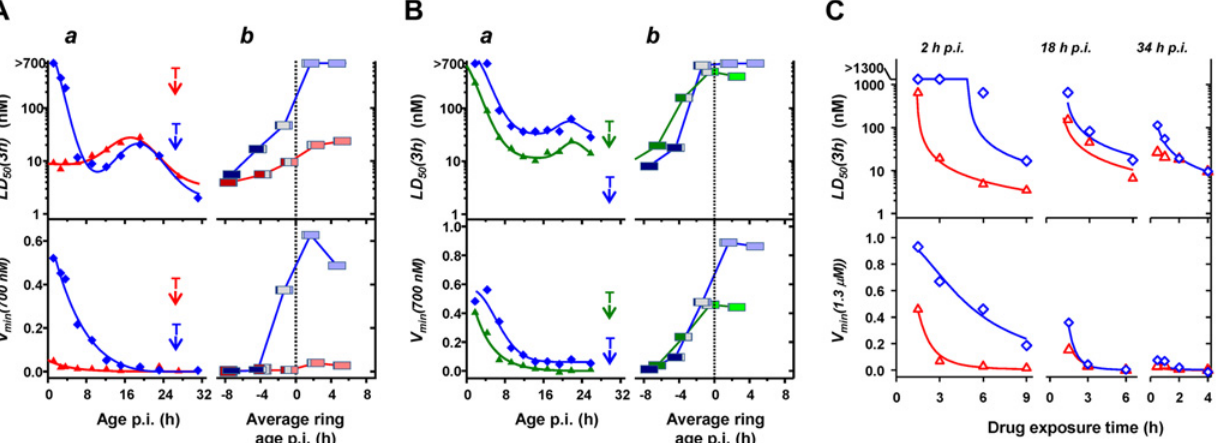
Fig 1. Stage-dependent in vitro DHA responses of Pailin strains. (A,B) Tightly synchronized PL2 and PL7 (A, red and blue, respectively) and PL1 and PL5 (B, green and blue, respectively) cultures were assayed using 3-h DHA pulses across the blood cycle. The a panels show the variation of LD 50 (3h) and V min (3h) during the first 32 h p.i. Time points corresponding to 50% trophozoites (T; filled cytoplasm in Giemsa stained smear) are indicated. The b panels show the variation of LD 50 (3h) and V min (3h) across the schizont-to-ring transition. Post-invasion ages are normalized to those in the next cycle to account for the different lifecycle durations of the different strains (49, 52, 59, and 57 h for PL1, 2, 5, and 7, respectively). Negative ages represent pre-invasion ages and correspond to schizonts that are the indicated time from forming new rings. The midpoint of each box corresponds to the average parasite age at the start of each assay, normalized to a value of zero when 50% of the parasites had formed rings. Colored bar widths reflect the relative parasite populations at the beginning of each assay: schizonts (dark blue for PL7 and PL5, dark red for PL2, and dark green for PL1), rings (light blue for PL7 and PL5, light red for PL2, and light green for PL1), and schizonts forming rings during the course of the assay (grey for all strains). (C) Tightly synchronized PL2 (red) and PL7 (blue) cultures were subjected to DHA pulses of different durations at 2, 18, and 34 h p.i. Curves represent best fits obtained with the cumulative effective dose (CED) model, with the parameters shown in Table 1. Dose response profiles for each exposure time are shown in S1 Fig.